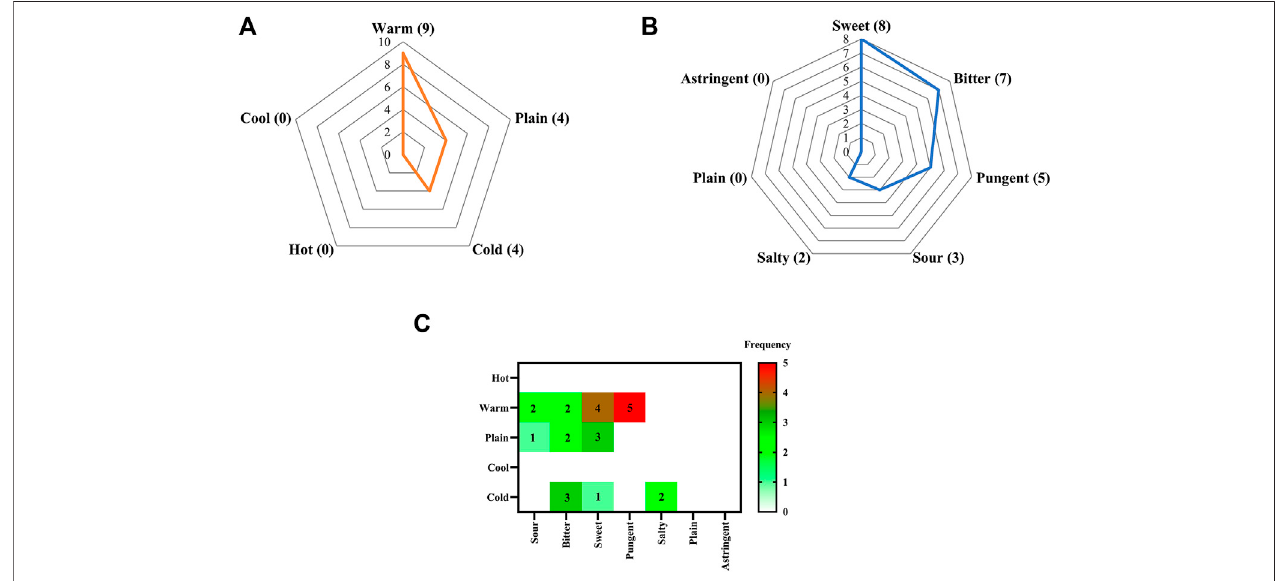
FIGURE4 | Flavor and property statistics and analysis charts of 17commonly used medicinal materials (A) Property radar plot (B) Flavor radar plot (C) Correlation heat map of fl avors and properties.